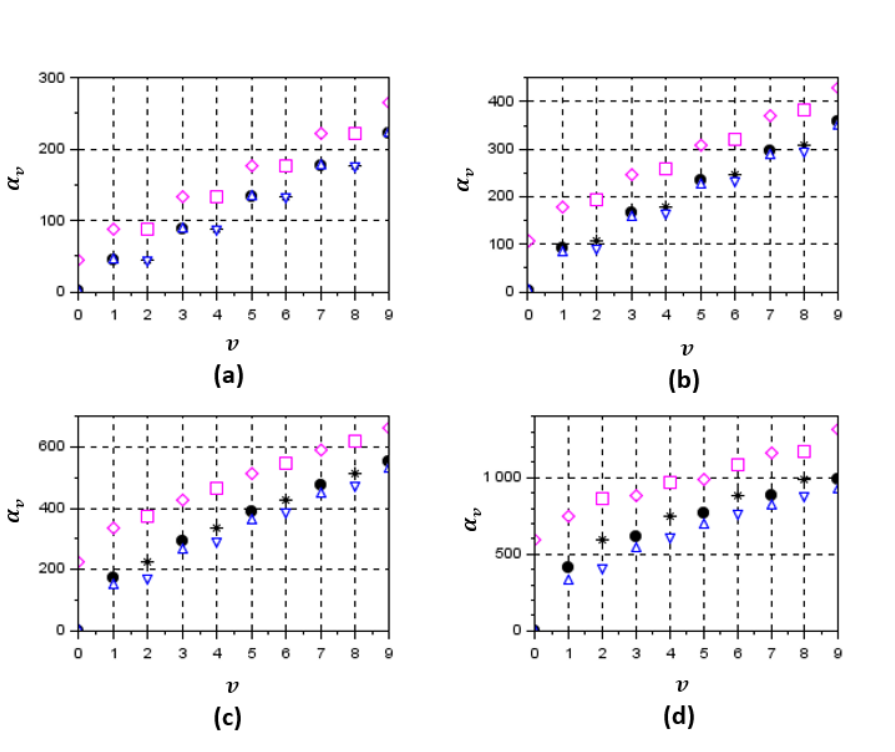
Figure 7: The variation of eigenvalue with the eigen-index for m = 0 with − σ . B (black solid circles) and + σ . B (black asterisks); m = + 1 with − σ . B (blue upward triangles) and + σ . B (blue downward triangles); m = − 1 with − σ . B (magenta dia- monds) and + σ . B (magenta squares) for (a) n = 0, (b) n = − 0.3, (c) n = − 0.5, and = 10 15 G pm − n (d) n = − 0.7. Here, B 0